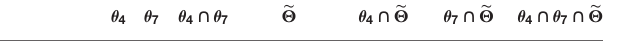
TABLE 5 | Final fusion